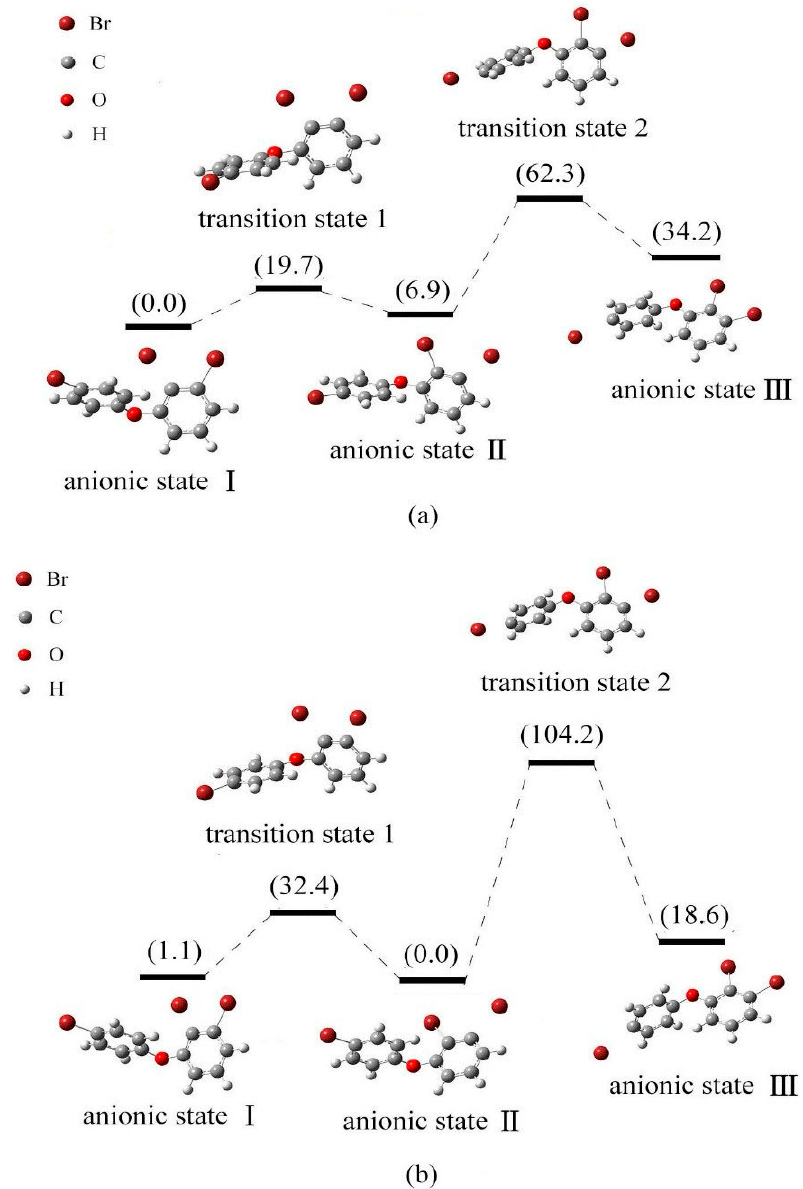
Figure 7. Relative energy of three possible anionic states and the transition states between them for BDE-22 (kJ/mol). (( a ) in gas phase; ( b ) in solution).